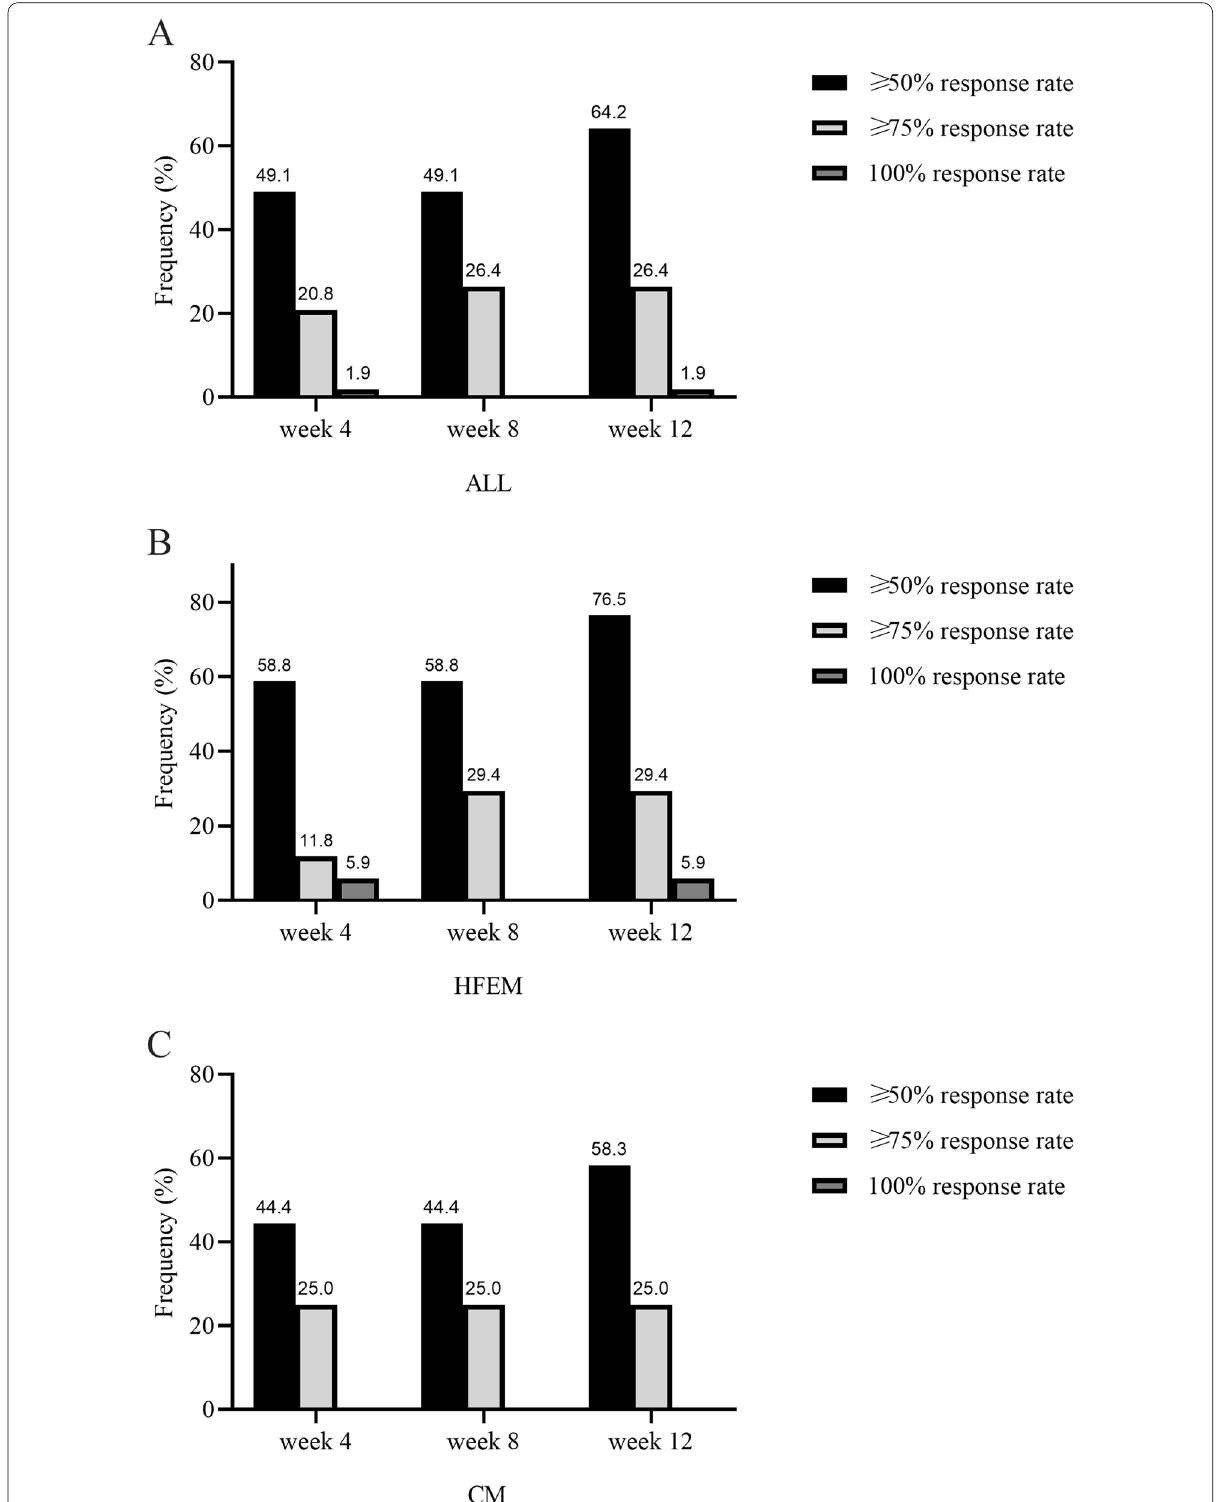
Fig. 3 Response rates at week 4, week 8, and week 12 in the global patients’ population (ALL), patients with high-frequency episodic migraine (HFEM), and chronic migraine